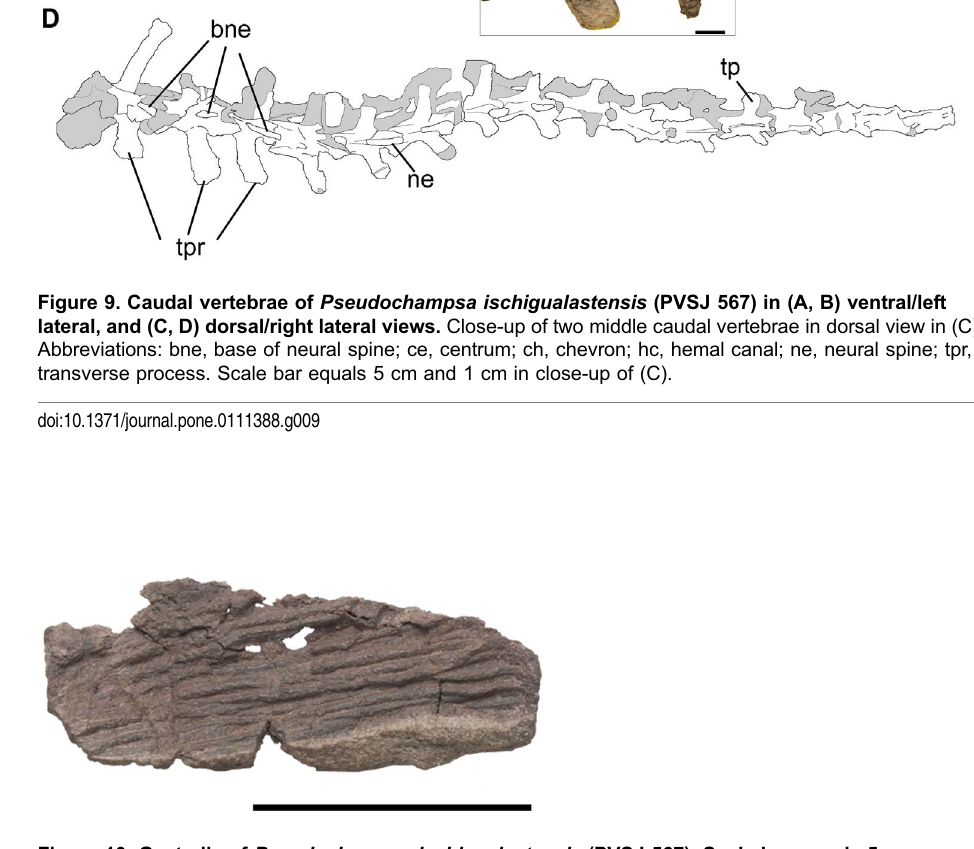
Figure 10. Gastralia of Pseudochampsa ischigualastensis (PVSJ 567). Scale bar equals 5